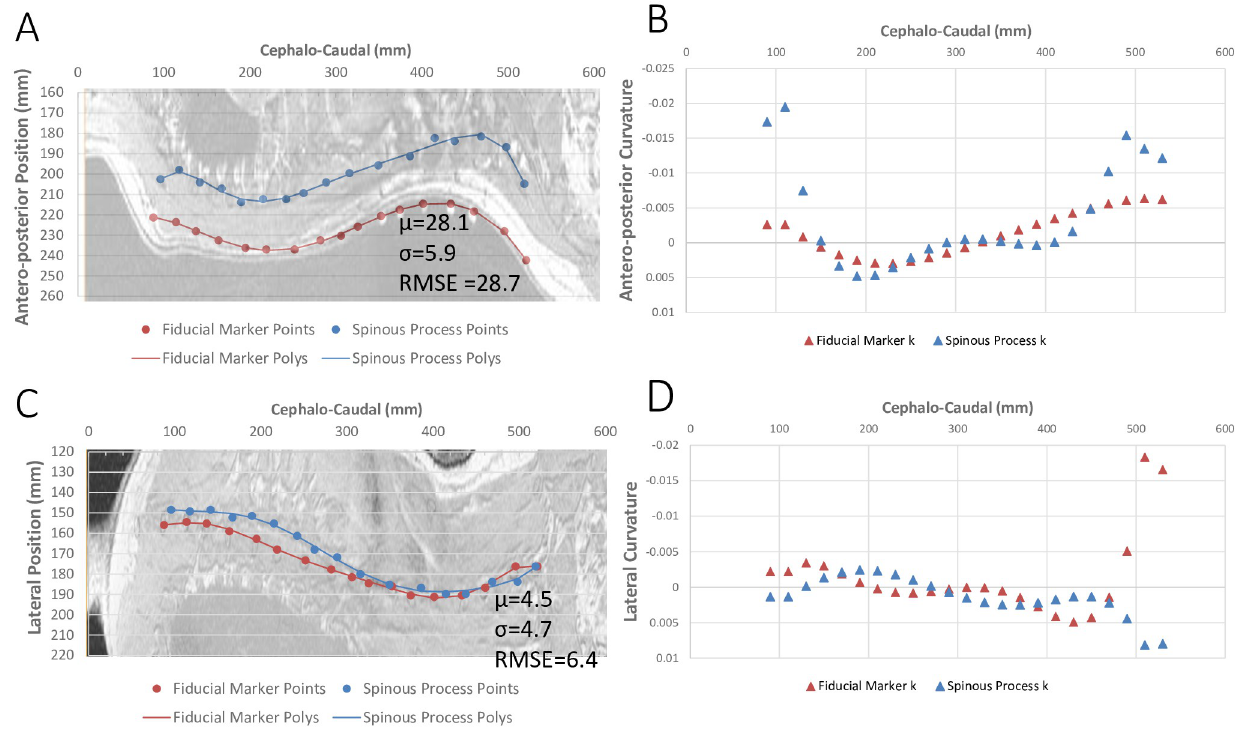
Fig 2. Position and curvature of spinous processes and surface fiducial markers. Position of fiducial markers (Red) and spinous processes (blue) compared in the sagittal (A) and coronal (C) planes with underlaid MR images (rescaled to the plot scale and aspect ratio). (A) The sagittal plane is displayed from the right lateral view, where the cephalo-caudal direction is displayed on the x-axis, and the antero–posterior direction on the y-axis. Participant 17 (shown) is used as an example of low RMSE with intersection in the coronal plane, and consistent distance in the Sagittal plane. (C) The coronal plane is displayed from the posterior view, where the cephalo-caudal direction is displayed on the x-axis, and left lateral direction is displayed on the y-axis. The curvature, k, in the sagittal view (B) and coronal view (D) are shown. μ = mean distance between profiles, mm; σ = standard deviation for the mean distance, mm; RMSE = root mean squared error,